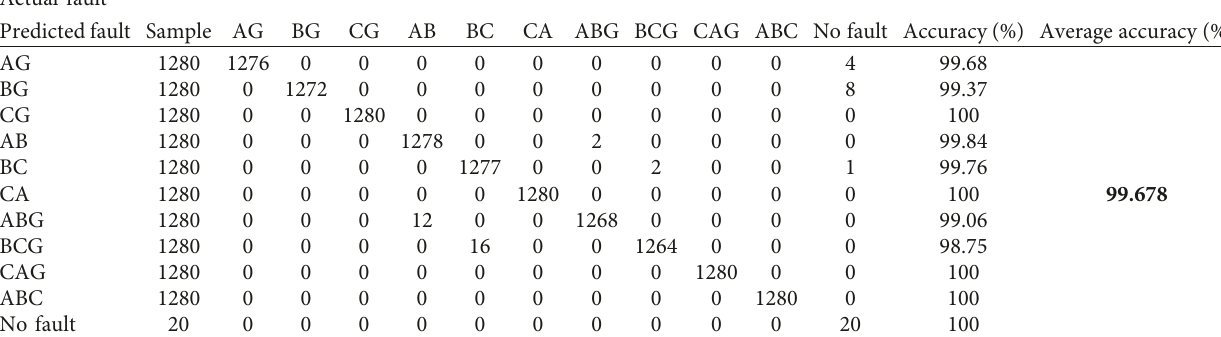
Table 13: Confusion matrix for the CDFTF-based scheme.